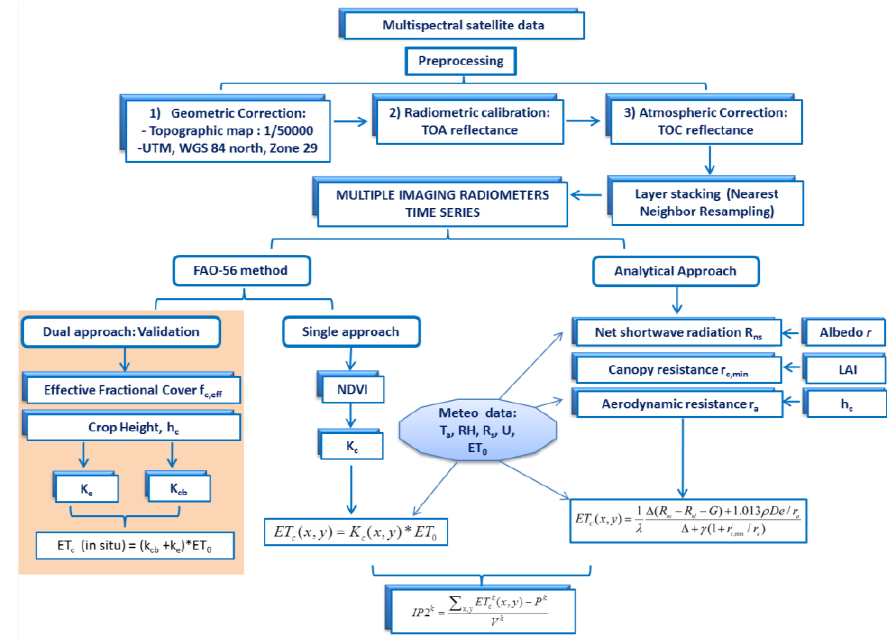
Figure 2. Workflow of the methodology